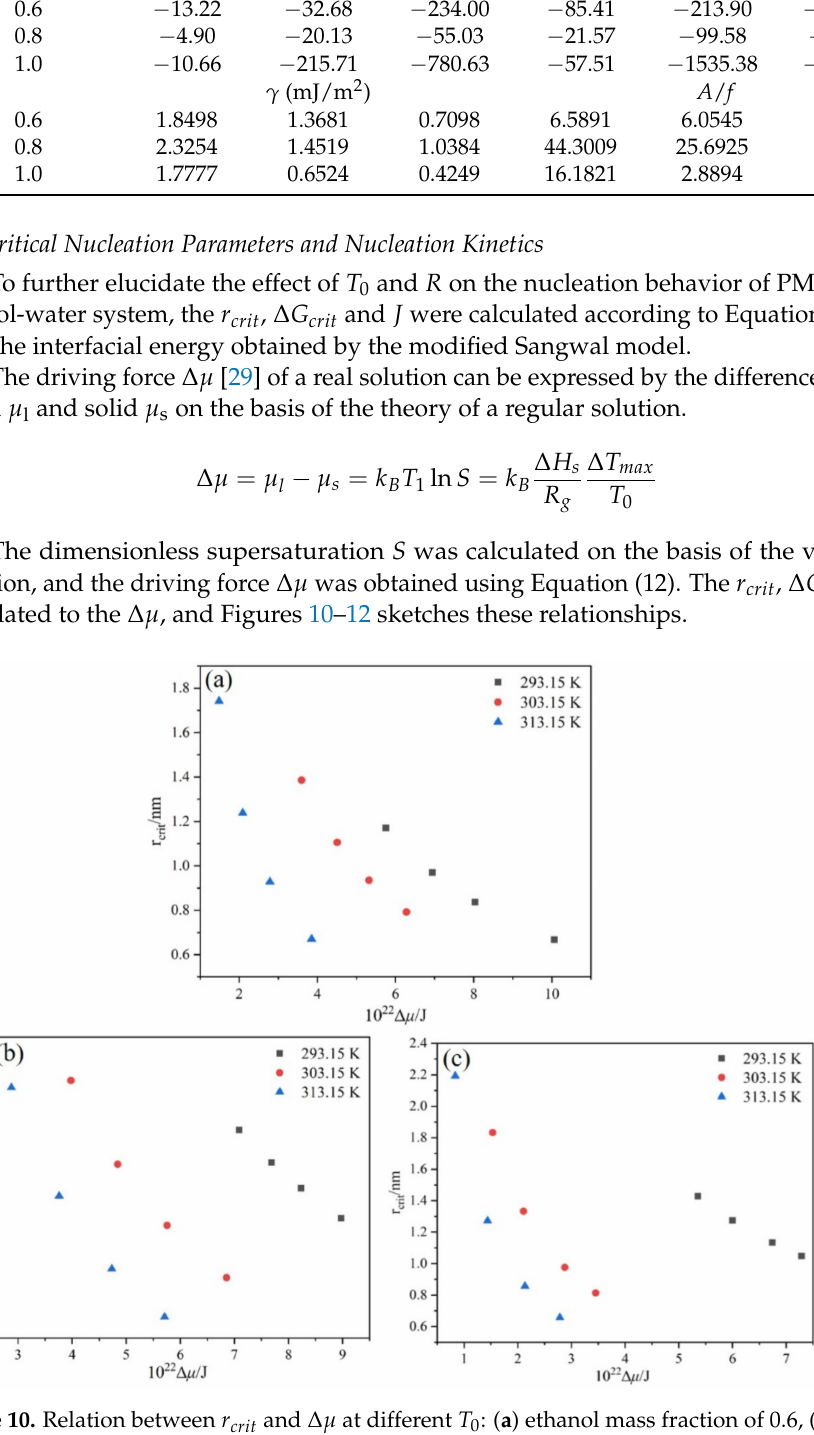
Figure 10. Relation between r crit and ∆ µ at different T 0 : ( a ) ethanol mass fraction of 0.6, ( b ) ethanol mass fraction of 0.8, ( c ) ethanol mass fraction of